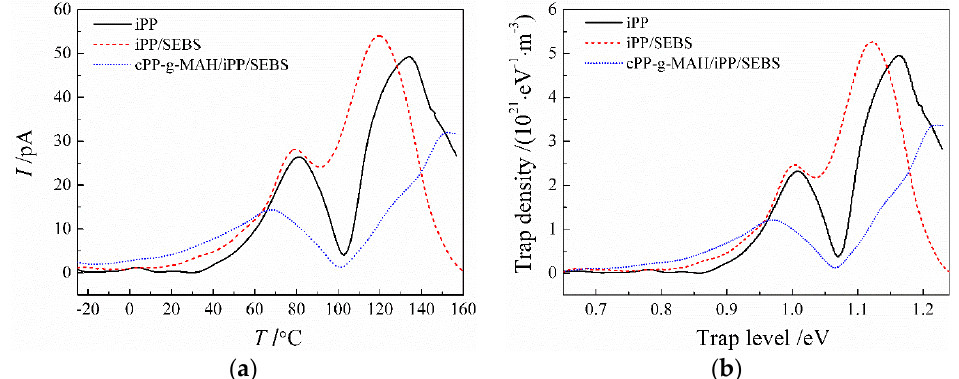
Figure 9. ( a ) Temperature spectra of thermally stimulated depolarization current (TSDC), and ( b ) the derived trap level distributions.